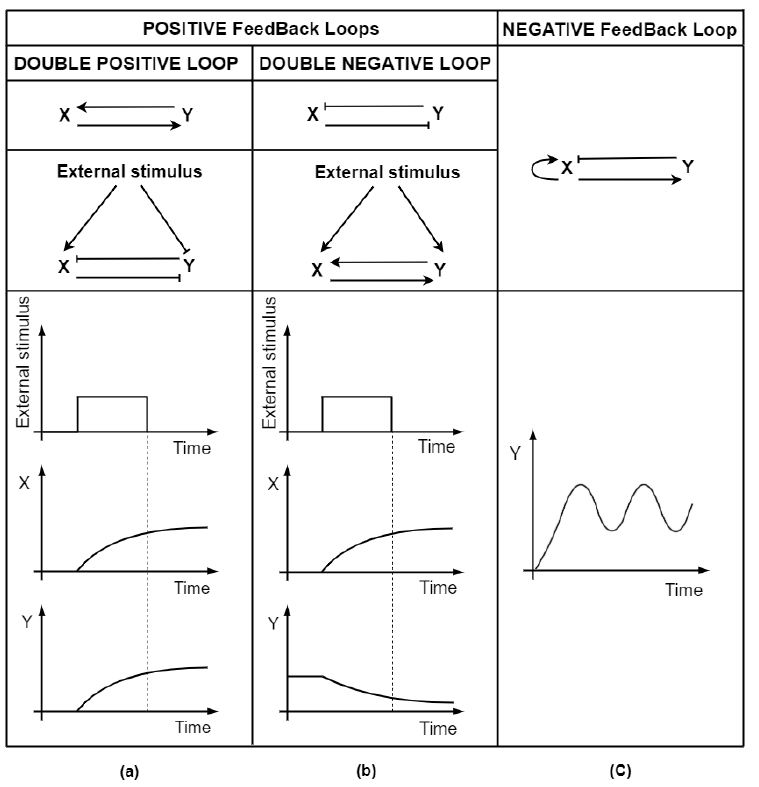
Figure 3. Representation of positive and negative feedback loops (P-FBL and N-FBL, respectively) and their signal-decoding properties. Edges with a pointed head represent positive (activatory) regulation, whereas edges with a flat head indicate negative (repressive) regulation. P-FBLs can be divided into two subgroups: double-positive loops and double-negative loops. ( a ) Upper panel: representation of the double-positive loop. Both regulatory paths are characterized by a positive sign. Middle panel: example of the memory-preservation property of the double-positive loop. A transient input stimulus that triggers the production of both X and Y leads their steady-state expression to remain switched on even after the deactivation (dashed line) of the input. ( b ) Upper panel: representation of the double-negative loop. Both regulatory paths are characterized by a negative sign. Middle and bottom panel: example of the memory-preservation property of the double-negative loop. A transient input stimulus that activates both X and Y leads their mutually exclusive steady-state expression, where one gene is active whereas the other is switched off, to remain locked even after the deactivation (dashed line) of the input. ( c ) Upper panel: representation of the N-FBL: regulatory paths are characterized by opposite signs. Typically, one of the two players is characterized by a positive auto-regulatory loop. Bottom panel: example of the oscillation-generating property of the N-FBL. Sustained oscillations can be generated by the N-FBL, provided that the two players are characterized by different timescales of